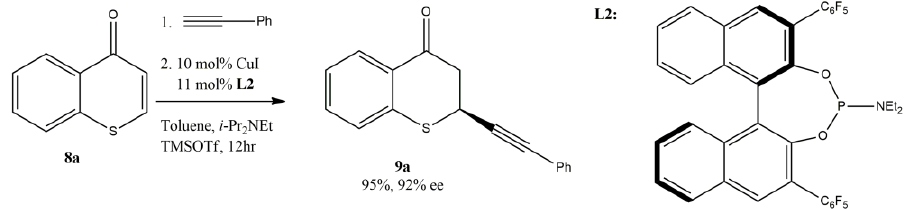
Figure 11. Enantioselective Cu-catalyzed alkynylation of thiochromones.